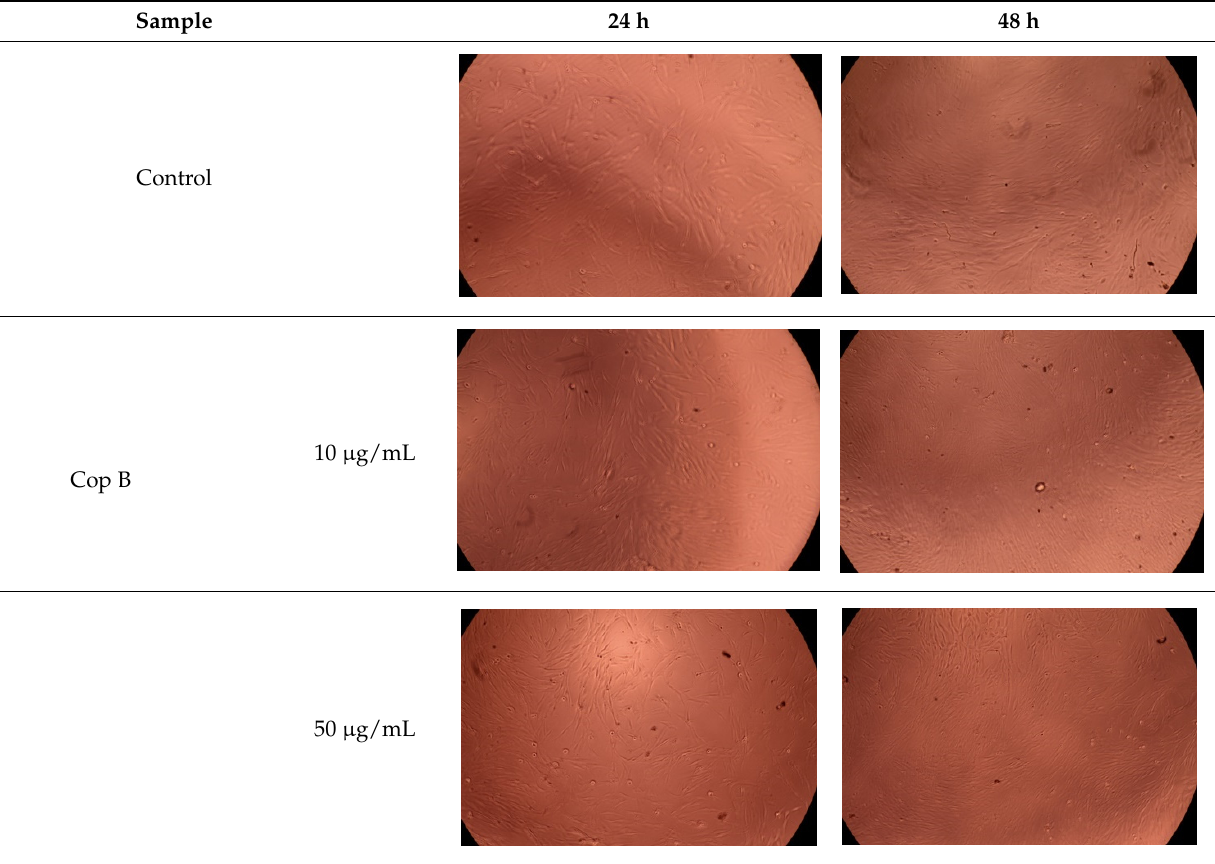
Table 2. Micrographs of fibroblast cells after 24 and 48 h incubation times, respectively.